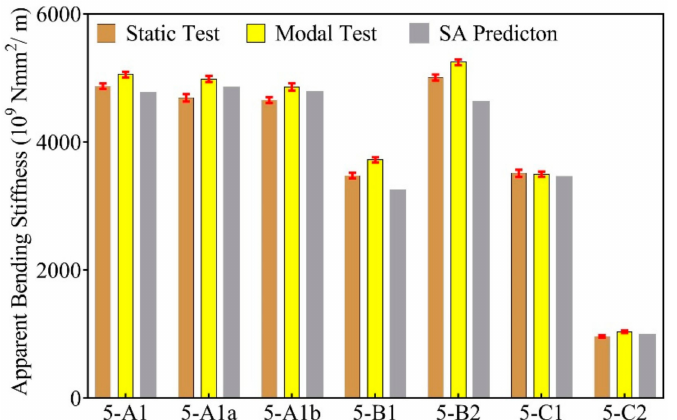
Figure 10. Apparent bending stiffness of 5-layer MTPs by bending test, modal test, and shear analogy method.